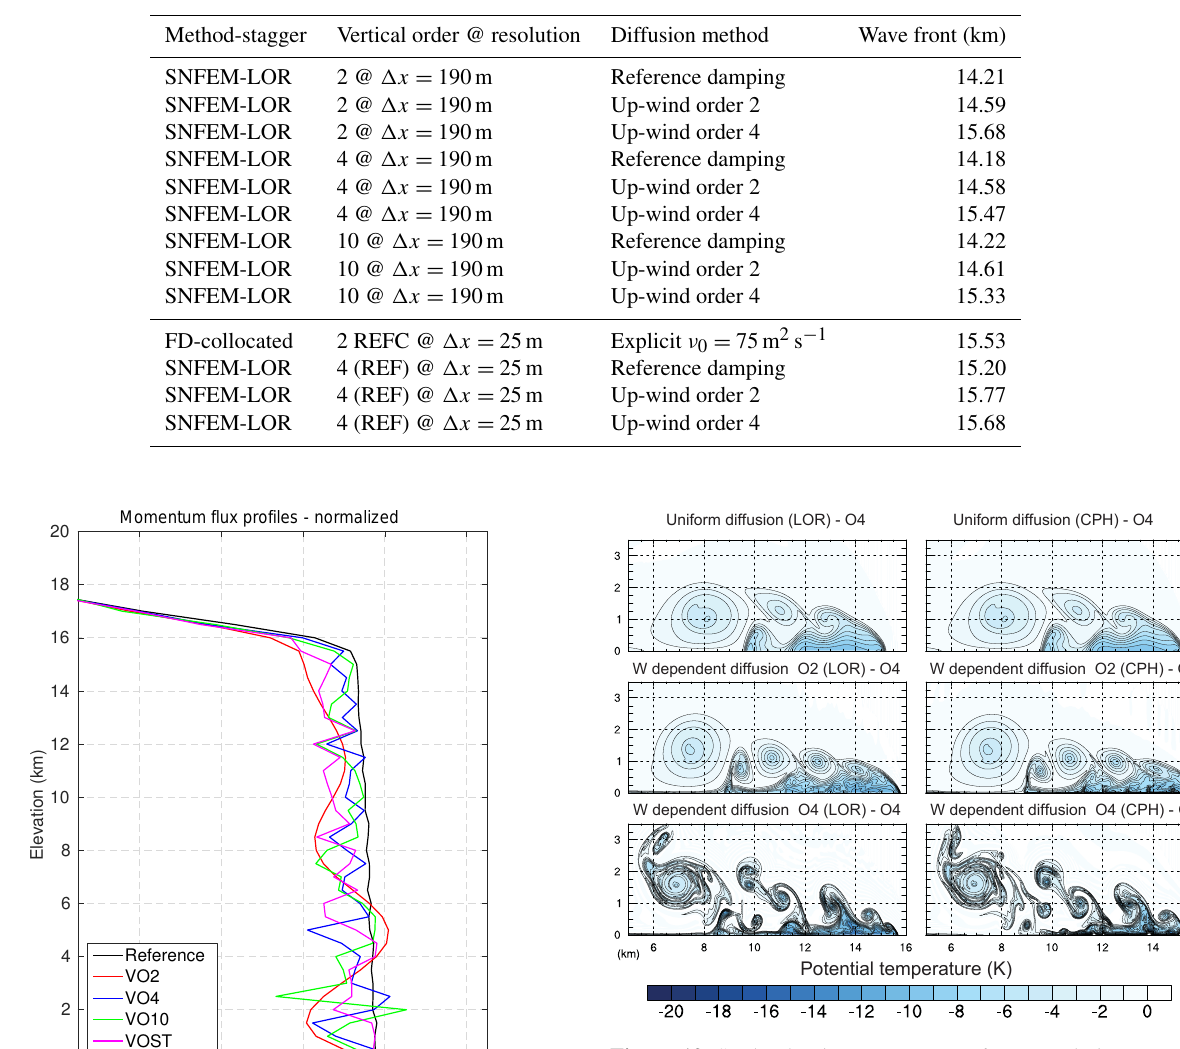
Figure 12. Straka density current test reference solutions at verti- cal order 4 in two staggering configurations LOR and CPH. Con- verged resolution of (cid:49)x = 25m and (cid:49)z = 25m shown. Vertical flow-dependent diffusion of order 2 and 4 (rows 2 and 3) is com- pared with the reference solution where an explicit second-order diffusion with ν 0 = 75m 2 s − 1 is used (top row). Contour interval: 1 .